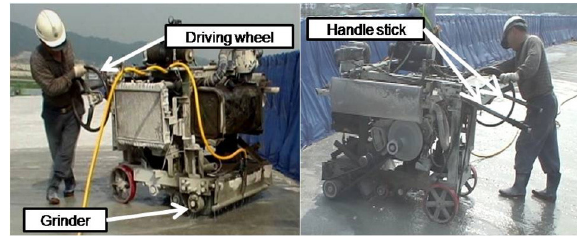
Fig. 1. Existing manually-operated concrete surface grinding